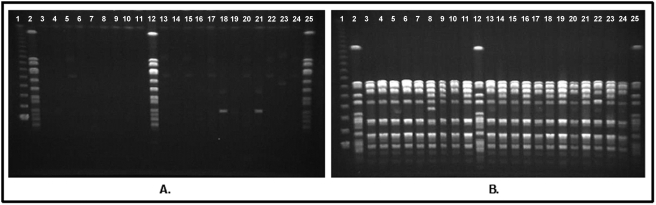
A: PFGE of MRSA isolates from swine and swine workers; DNA digested with SmaI. B: PFGE of MRSA isolates from swine and swine workers; DNA digested with EagI. Lane 1: molecular weight ladder. Lanes 2, 12, 25: NCTC 8325 (control strain). Lanes 3–11: isolates from swine workers. Lanes 13–24: isolates from swine.